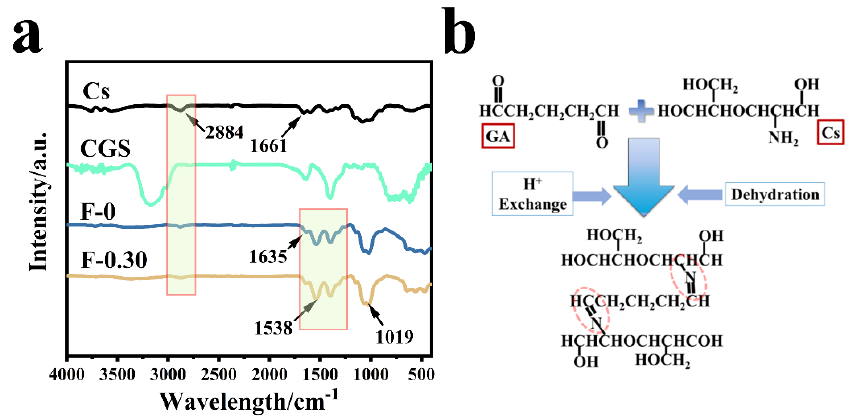
Figure 6. ( a ) The infrared spectra of different samples; ( b ) the formation process of Schiff base.